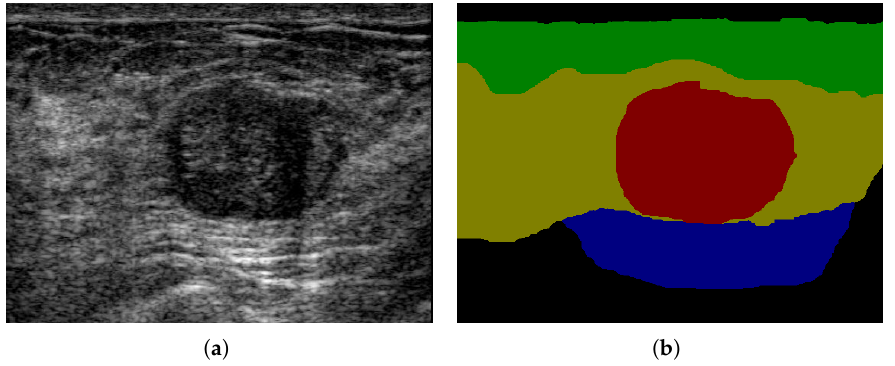
Figure 1. Breast anatomy: ( a ) BUS image; ( b ) ground truth; green: fat layer, yellow: mammary layer, blue: muscle layer, red: tumor, and black: